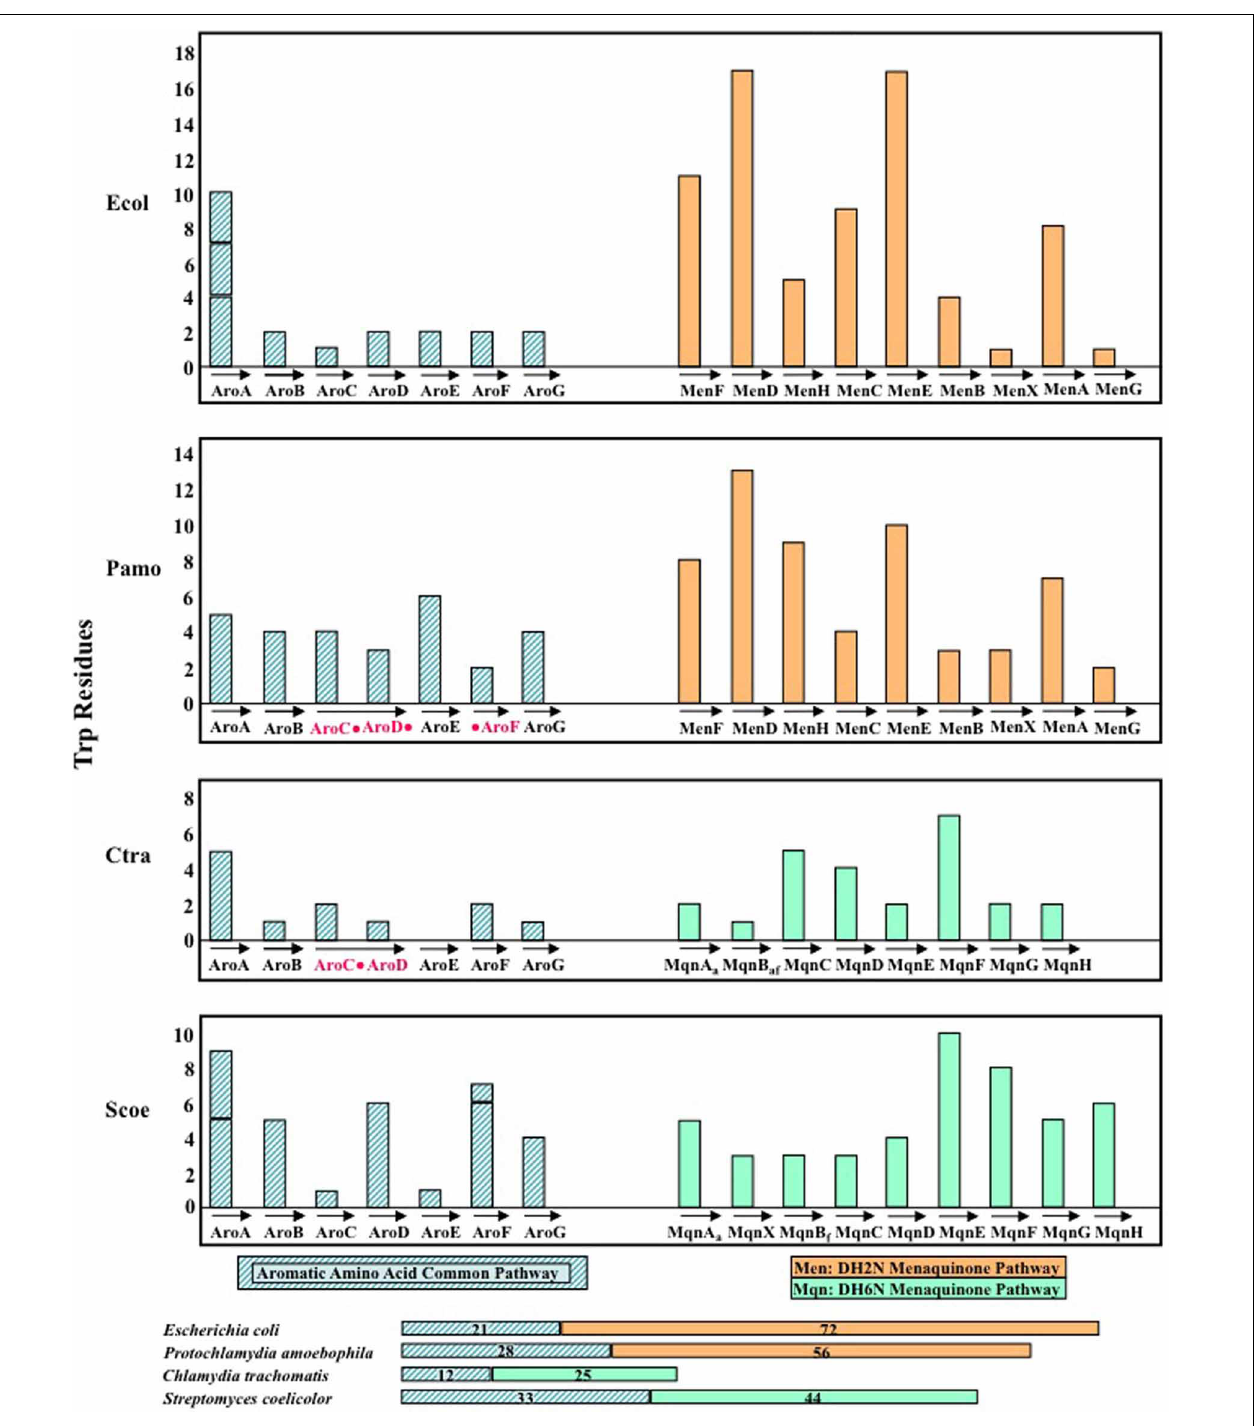
FIGURE 7 | Comparison of the Trp content of the chorismate/menaquinone pathway in Chlamydia trachomatis (Ctra), its close relative Protochlamydia amoebophila (Pamo), the classic bacterium Escherichia coli (Ecol), and Streptomyces coelicolor (Scoe). Pamo and Ecol both utilize the classic DH2N pathway for menaquinone biosynthesis, and this is represented by the orange histogram bars. On the other hand, Ctra and Scoe both utilize the DH6N pathway, and this is indicated by the green histogram bars. Note by relating the acronyms